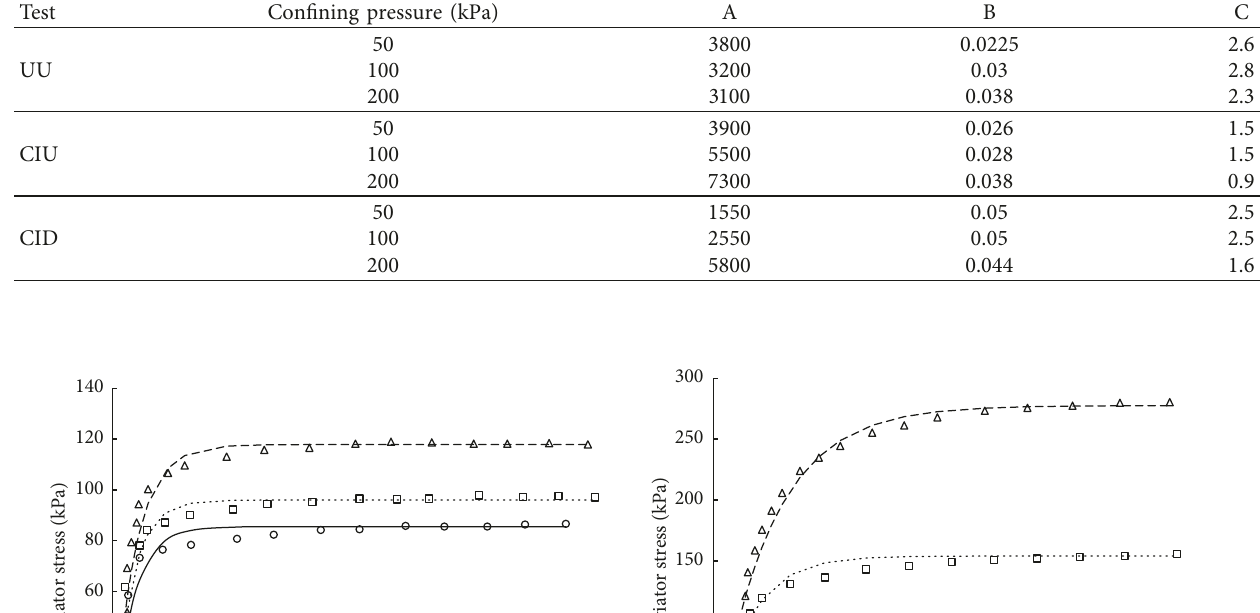
Table 2: Fitting parameters for stress-strain curves.